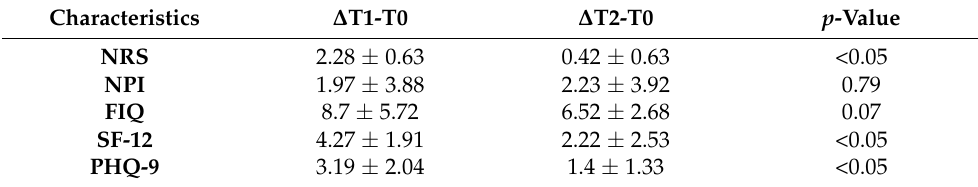
Table 4. Comparison of the variations in the score of the evaluation scale between the two groups. Characteristics ∆ T1-T0 ∆